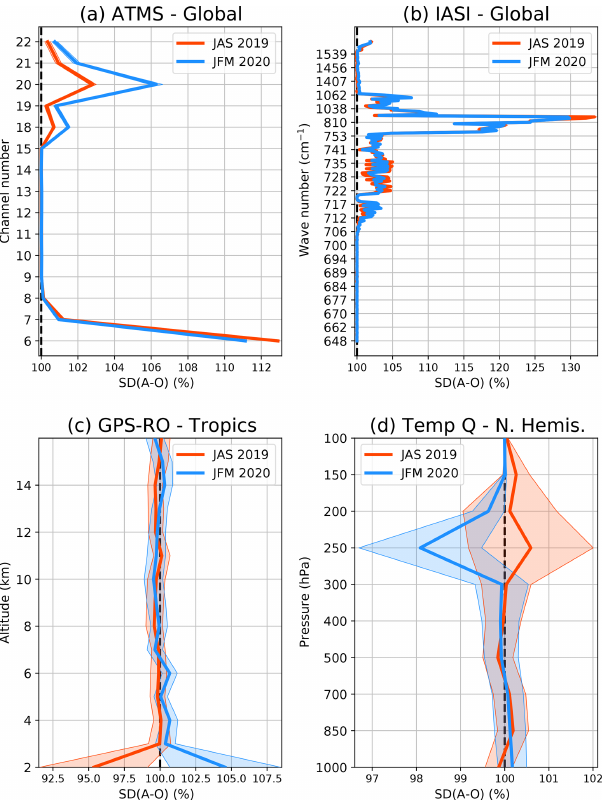
Figure 6. Normalised analysis fit to observations (in %) for vari- ous observation types (see panel headings) for JAS 2019 (red) and JFM 2020 (blue). The shaded area represents the variability (1 stan- dard